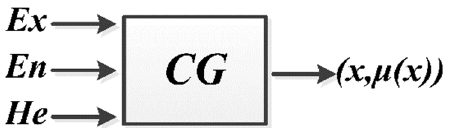
Figure 3. Schematic diagram of forward cloud generator operation.